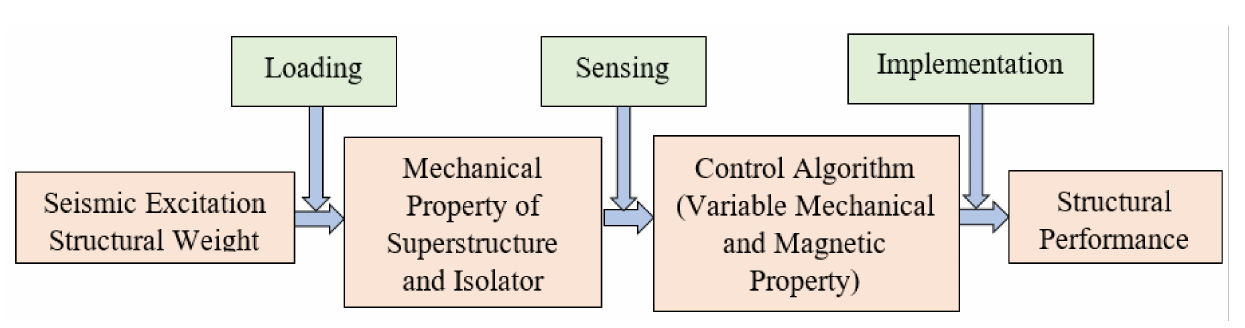
Figure 17. Structural Vibration Control